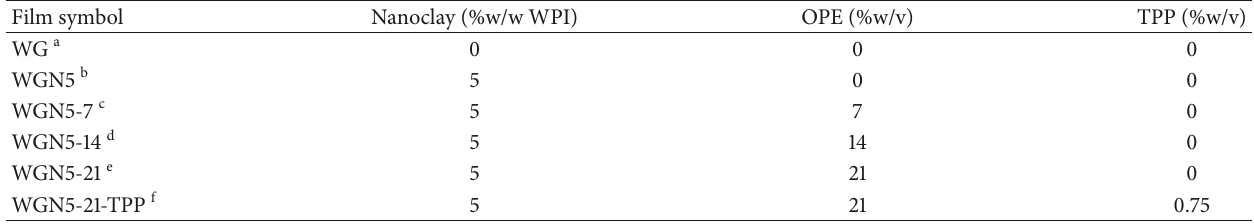
Table 1: Different concentrations of components for preparing films and their